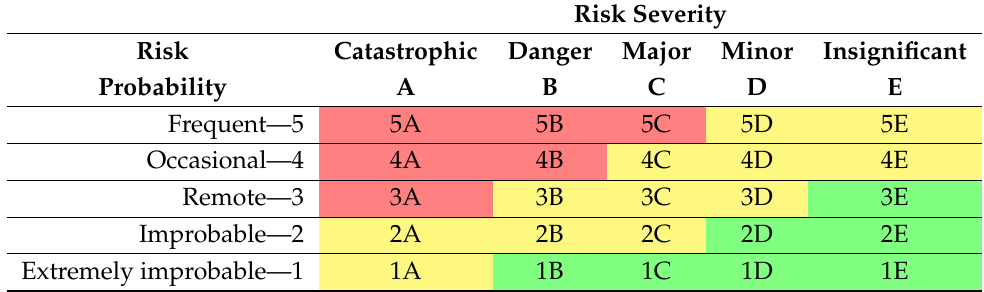
Table 1. Risk matrix